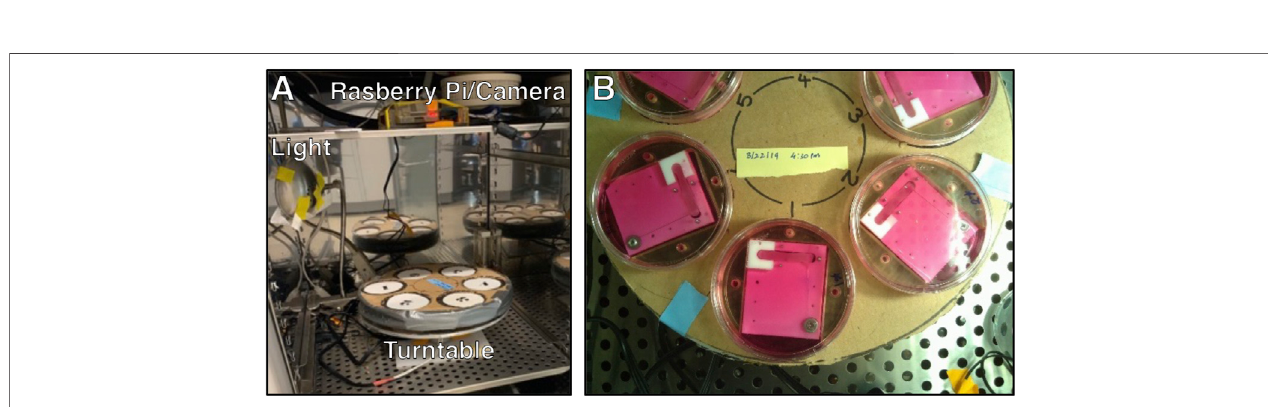
FIGURE 4 | (A) The bioreactor turntable and imaging system inside a dedicated incubator. (B) View of the turntable from the Raspberry Pi